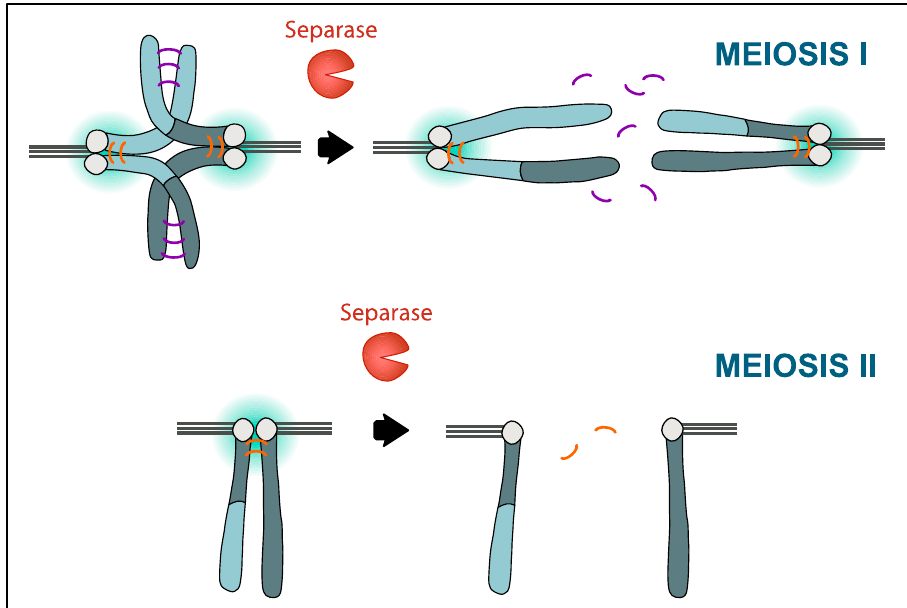
Figure 1. Protection of centromeric cohesin in meiosis I and II. Chromosomes that have recombined (indicated by different color shades), consisting of two sister chromatids each, are held together by cohesin complexes on chromosome arms (indicated in purple) and within the centromere region (orange). Of note, chromosomes in the mouse are telocentric, resulting in the typical cross-shaped appearance of homologous chromosomes in meiosis I. Around the centromere, cohesin is protected by the activity of PP2A-B56 (gradient in turquoise). At the metaphase-to-anaphase transition in meiosis I, Separase is activated and cleaves the cohesin kleisin subunit Rec8 on chromosome arms, to bring about chiasmata resolution and allow segregation of homologous chromosomes to the opposite poles of the spindle. In meiosis II, centromeric cohesin is deprotected at anaphase II onset, allowing Separase to remove the remaining cohesin holding sister chromatids together and hence, their separation. How deprotection of centromeric cohesin is regulated in oocytes to take place only in meiosis II is still unclear.